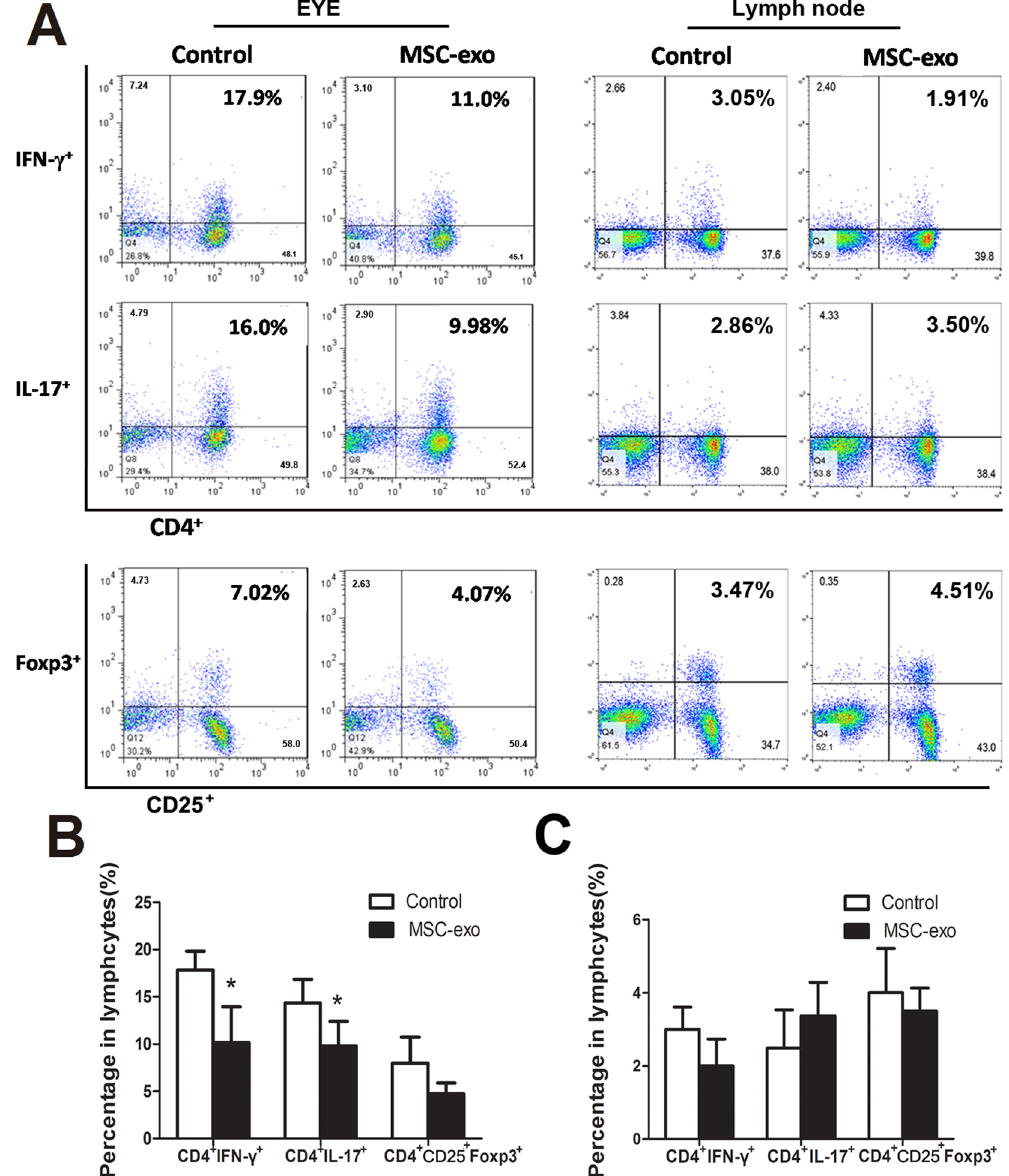
Figure 6. Analysis of T cell subsets from eye and lymph node. For CD4 + CD25 + Foxp3 + cell detection, cells were first gated on CD4 + cells, and then gated on CD25 + and Foxp3 + cells. ( A ) Representive figures of intracellular staining of IFN- γ , IL-17 and CD25 + Foxp3 + in eyes-derived CD4 + T cells (left) and in lymph nodes-dvrived CD4 + T cells (right) from Control and MSC-exo treated rats with EAU. ( B ) the percentage of CD4 + IFN- γ + , CD4 + IL-17 + and CD4 + CD25 + Foxp3 + cells in eyes. ( C ) the percentage of CD4 + IFN- γ + , CD4 + IL-17 + and CD4 + CD25 + Foxp3 + cells in cervical draining lymph nodes. Values are expressed as the mean ± SD of six rats (12 eyes) per group. * P <